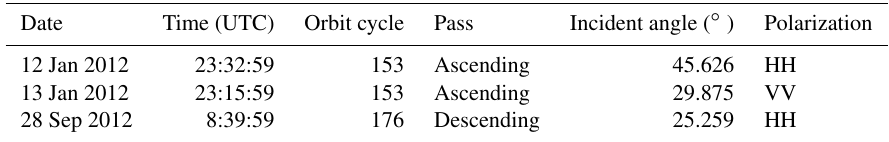
Table 1. Characteristics of the TerraSAR-X scenes used for snow mapping on Fildes